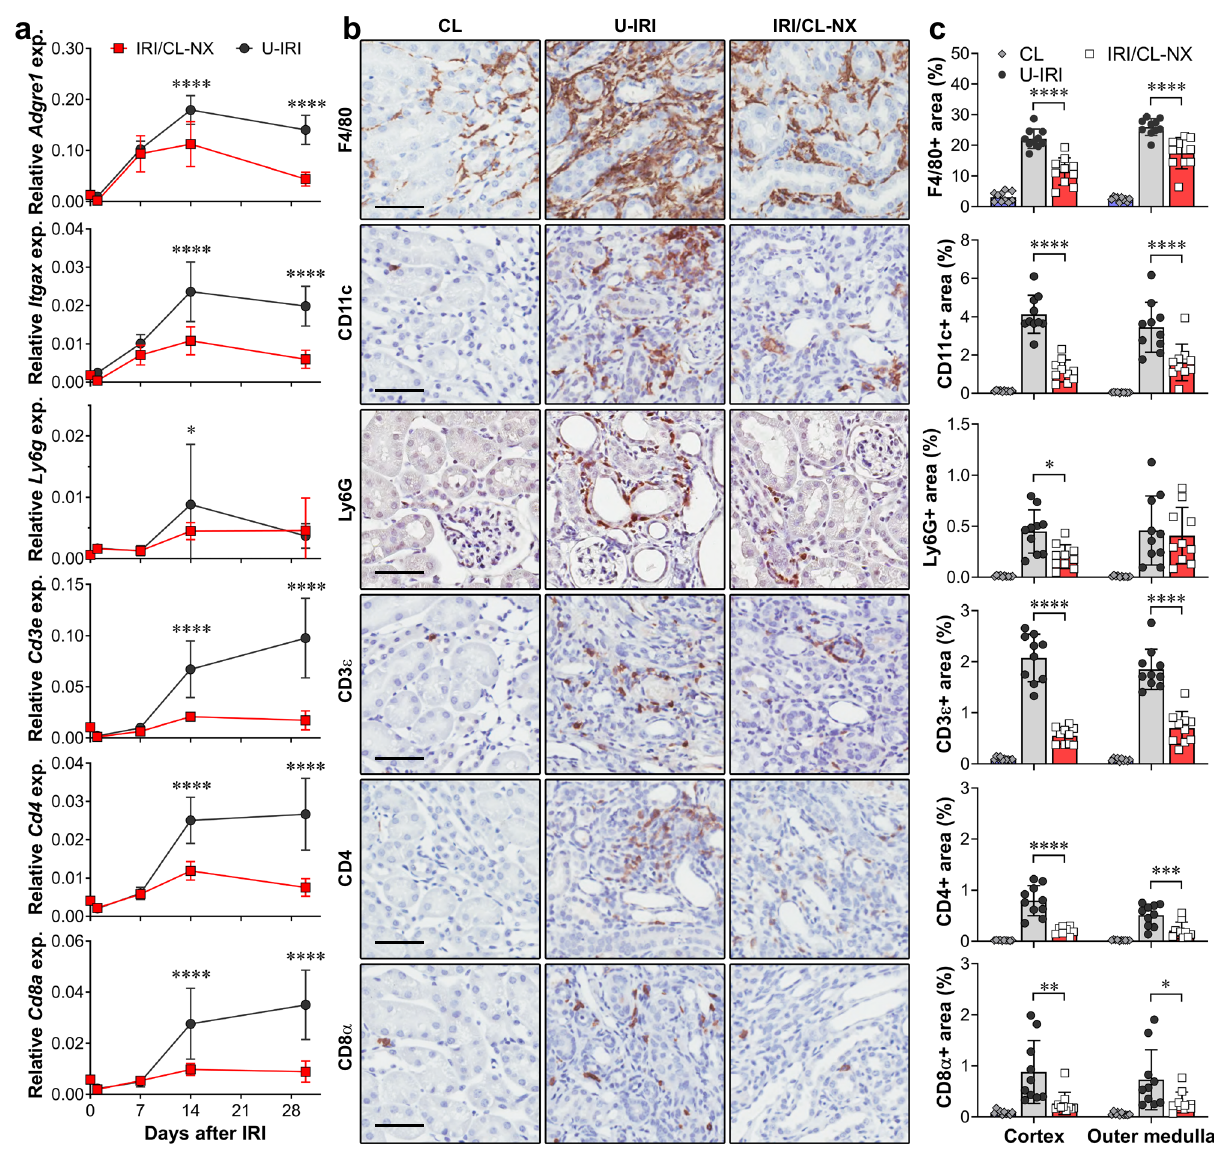
Fig. 4 | U-IRI promotes late immune cell accumulation. Wild-type mice were subjected to 27min of ischemia/reperfusion injury (IRI) with contralateral nephrectomy (IRI/CL-NX) or unilateral IRI (U-IRI) and sacri fi ced on day 1, 7, 14,and 30 after injury. The injured kidneys and normal control kidneys (de fi ned as day 0) wereanalyzed. a QuantitativeRT-PCRanalysisfor Adgre1 (F4/80), Itgax , Ly6g , Cd3e , Cd4 , and Cd8a was performed on whole-kidney RNA. Data are presented as mean±SD. n =10 kidneys/time point/model. Two-way ANOVA is summarized in Supplementary Table 1. * p <0.05 ( p =0.0449), **** p <0.0001 at the indicated time